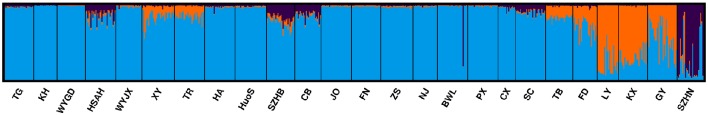
Inferred population structure of L. formosana in China using program STRUCTURE (K = 3). Each individual is represented by a single vertical line, which is partitioned into colored segments in proportion to the estimated membership in 3 groups: blue for Group 1, orange for Group 2, and purple for Group 3.